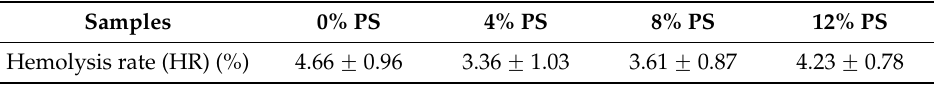
Table 2. Hemolysis assay of different PS-containing Cur-mNLCs (mean ± SD, n = 3).